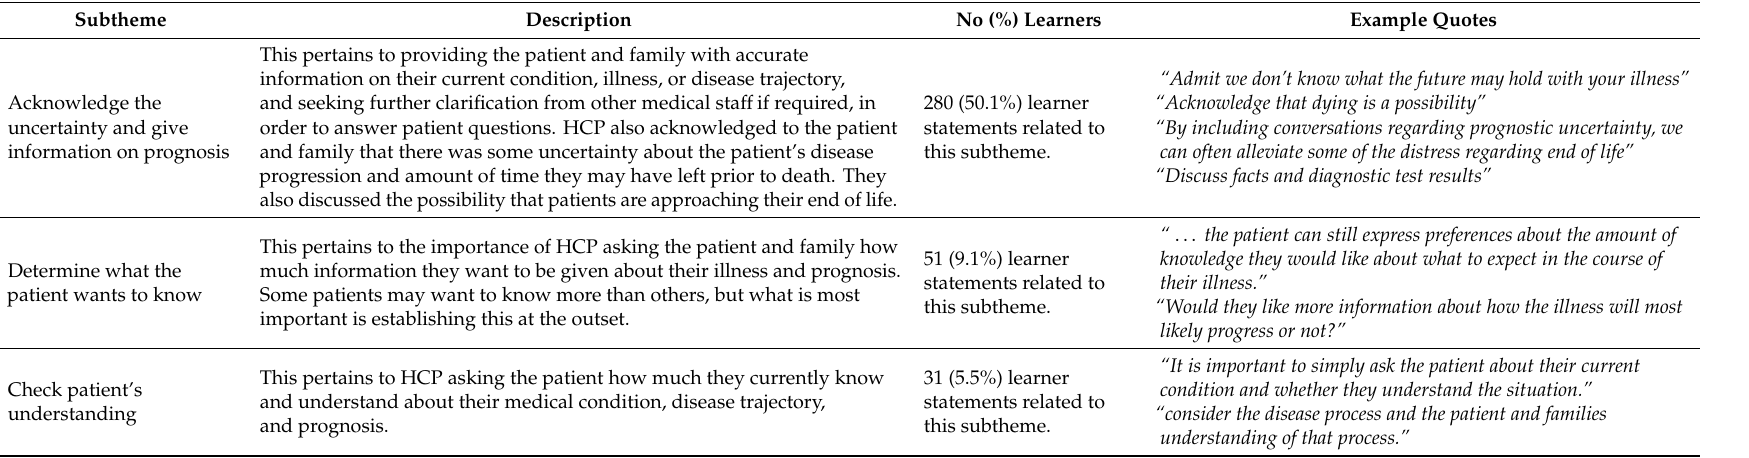
Table 2. Discussion of prognosis subtheme descriptions.